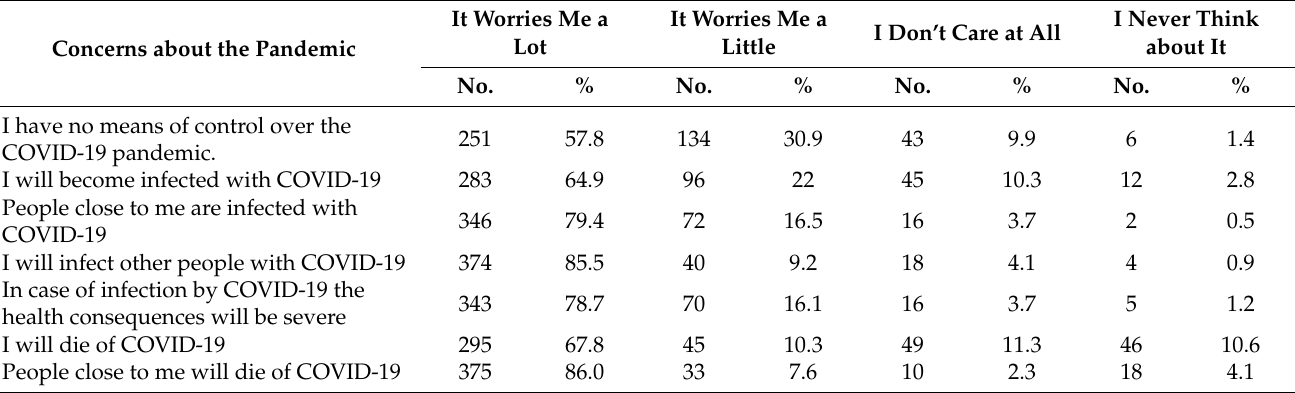
Table 3. Concerns about the